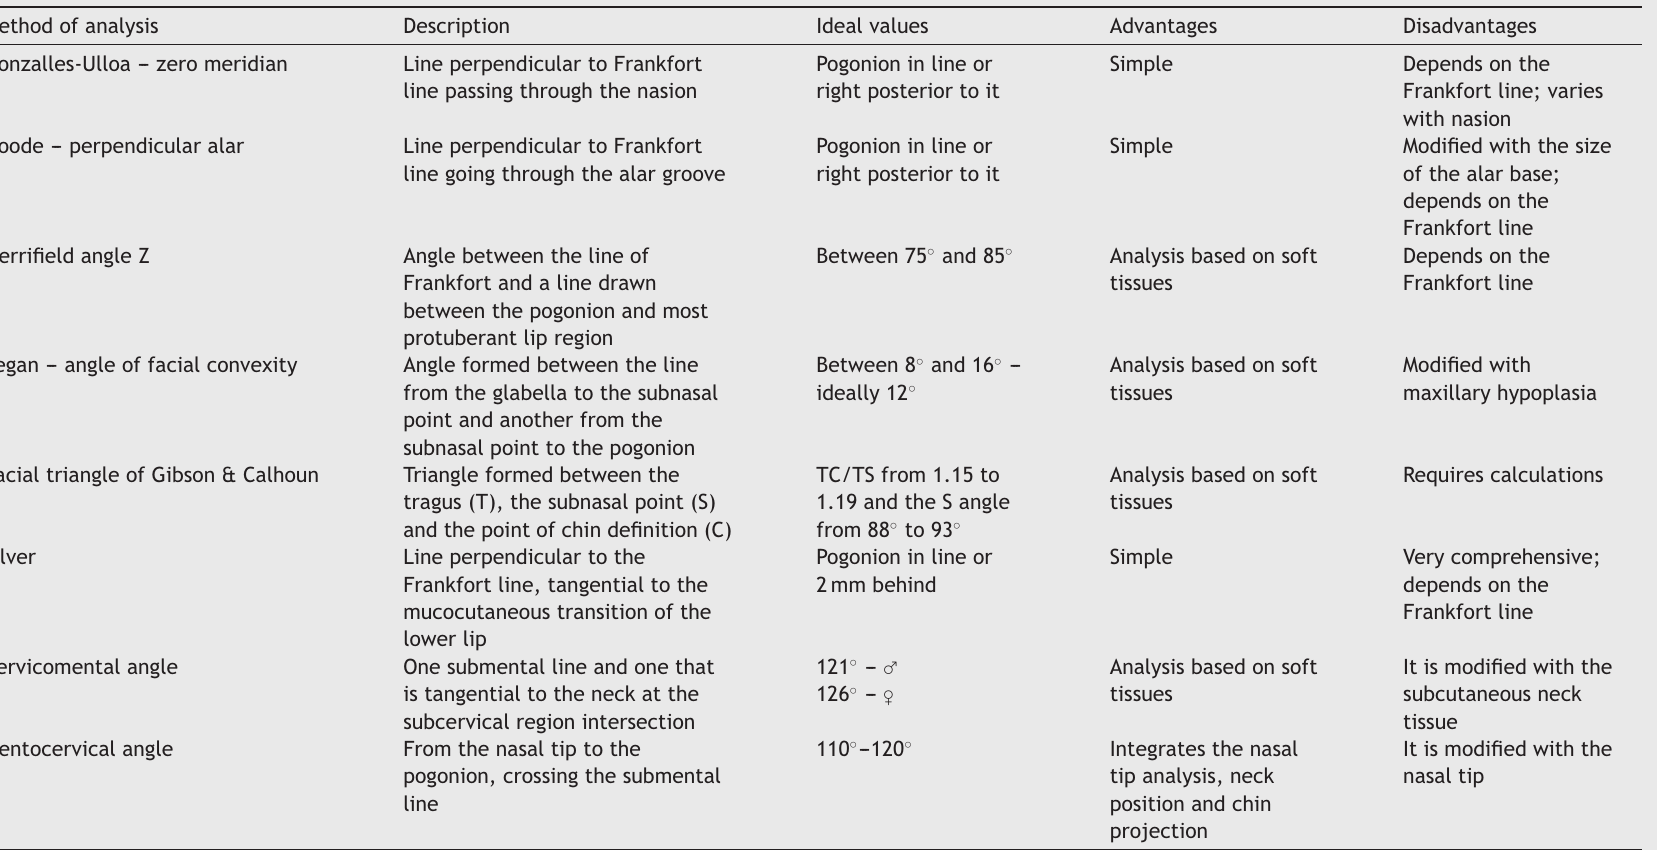
Comparison of the main methods for chin position